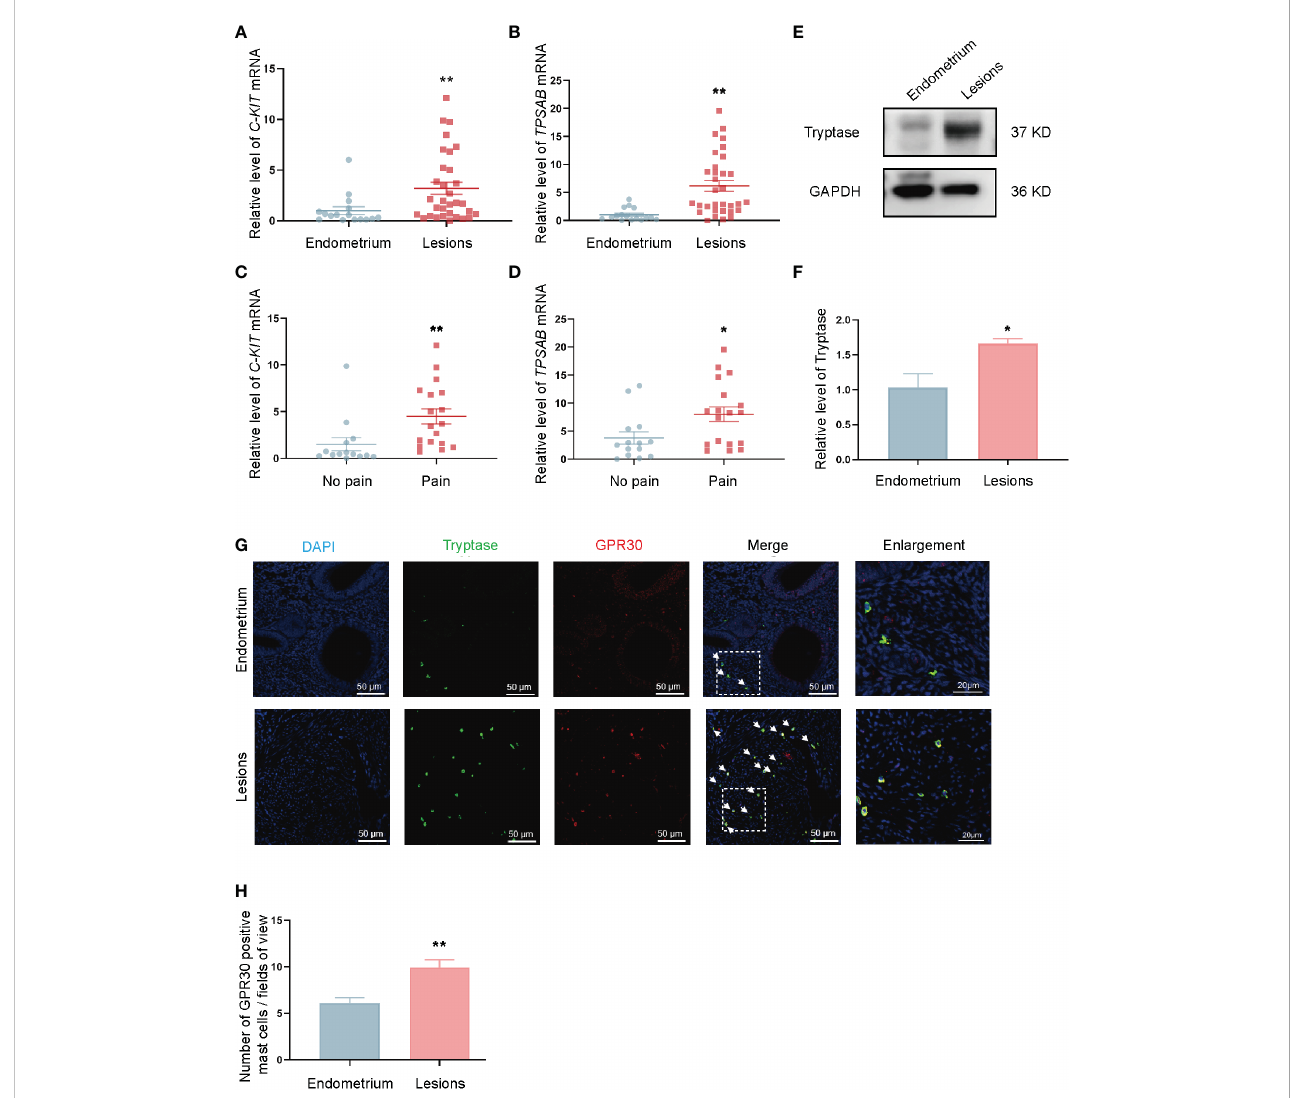
FIGURE 1 Number of GPR30 positive mast cells is increased in ovarian endometriotic lesions. (A) The mRNA level of C-KIT in control endometrium (n = 16) and ovarian endometriotic lesions (n = 32). (B) The mRNA level of TPSAB1 in control endometrium (n = 16) and ovarian endometriotic lesions (n = 32). (C) The mRNA level of C-KIT in ovarian endometriotic lesions from patients with (n = 18) or without (n = 14) endometriosis-related pain. (D) The mRNA level of C-KIT in ovarian endometriotic lesions from patients with (n = 18) or without (n = 14) endometriosis-related pain. (E) Western blot analysis of tryptase in lesions from control endometrium and ovarian endometriotic lesions. (F) Relative expression of tryptase in lesions from control endometrium (n = 11) and ovarian endometriotic lesions (n = 16). GAPDH was used as reference protein. (G) Representative double immuno fl uorescence images of tryptase (green) and GPR30 (red) in lesions from control endometrium and ovarian endometriotic lesions; white arrow indicated the positive cells, 400×, bar = 50 m m. Boxed region of the merged images was enlarged on the right, bar = 20 m m. (H) Number of GPR30 positive mast cells per fi elds of view in control endometrium (n = 11) and ovarian endometriotic lesions (n = 16). Endometrium: endometrium tissue from patients without endometriosis, Lesions: ovarian endometriotic lesions from patients. No pain: lesions from patients without endometriosis-related pain, Pain: lesions from patients with endometriosis-related pain. * P < 0.05, ** P <